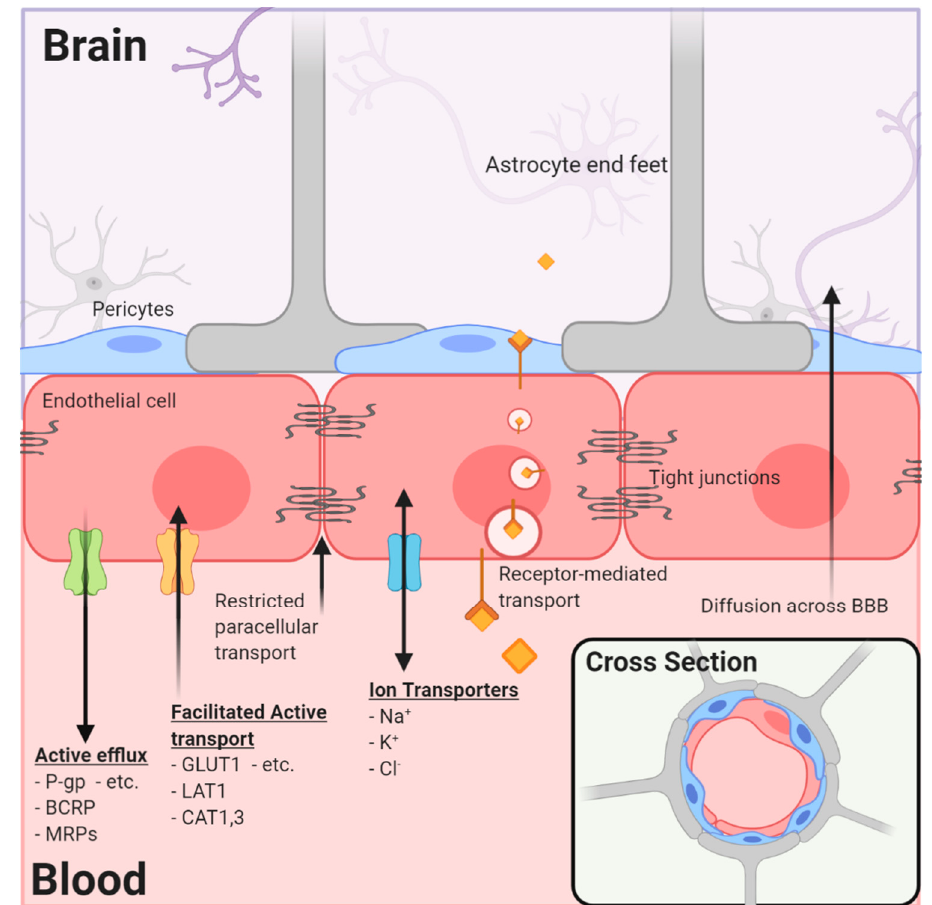
Figure 1. The neurovascular unit/blood–brain barrier (NVU/BBB) is composed of specialized endothelial cells and support cells, including pericytes and astrocytes. The cross-sectional view illustrates that the majority of the abluminal surface of the endothelial cell is covered by pericytes and astrocytic foot processes. Paracellular transport across the BBB/NVU is restricted by tight junction proteins, and even small, lipophilic molecules that might diffuse across the BBB may be subject to active efflux by a variety of proteins. Facilitated active transport, receptor-mediated transport, and ion transporters allow the brain to be supplied with nutrients while maintaining strict homeostasis.